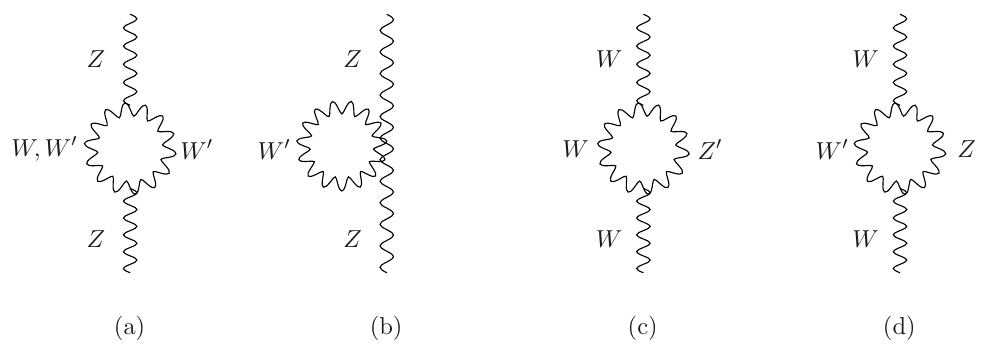
Figure 2 . Self-energy diagrams for the W and Z bosons in Left-Right models: only gauge bosons are considered in the